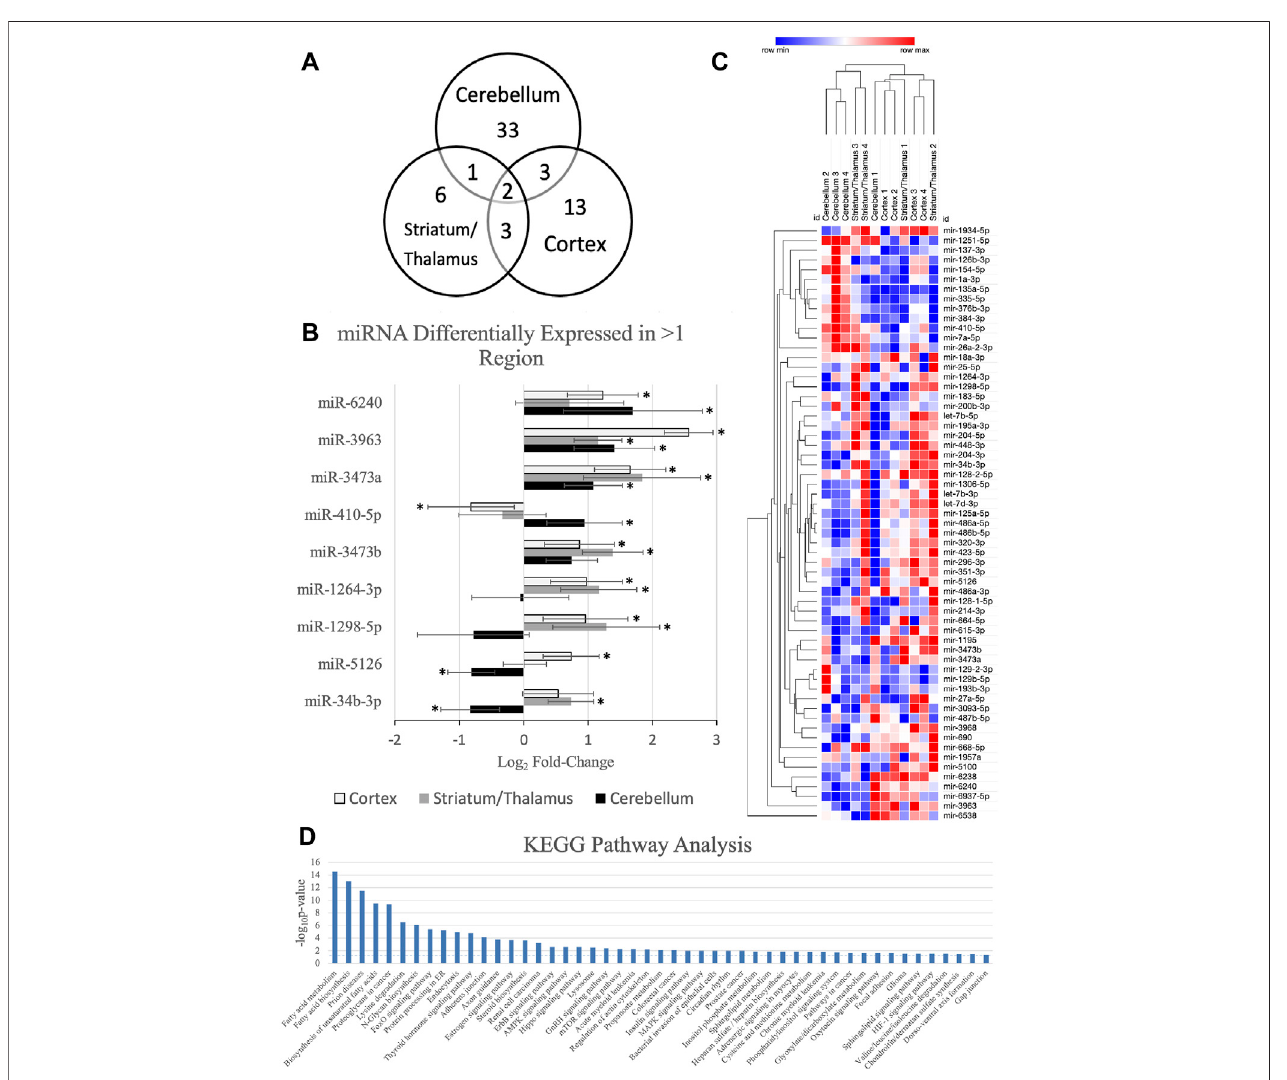
FIGURE 2 | MicroRNAs (miRNA) with signi fi cant differential expression in more than one region. (A) Venn diagram demonstrating the number of miRNAs with signi fi cant differential expression and the overlap between each region; (B) differential expression of the nine miRNAs with signi fi cant differential expression in more than one region (*regional expression signi fi cant, as de fi ned by fold-change > 1.5, p value < .05, and average count per million reads > 10); (C) two-way unsupervised clustering of differentially expressed microRNAs demonstrating separation of the majority of the cerebellum samples from the cortex and striatum/thalamus samples. Rows represent microRNA species and columns represent samples. Each square represents expression in a single sample, color-coded for magnitude of change relative to controls; and (D) KEGG pathway analysis of the miRNAs with signi fi cant differential expression. Error bars represent standard error of the mean.